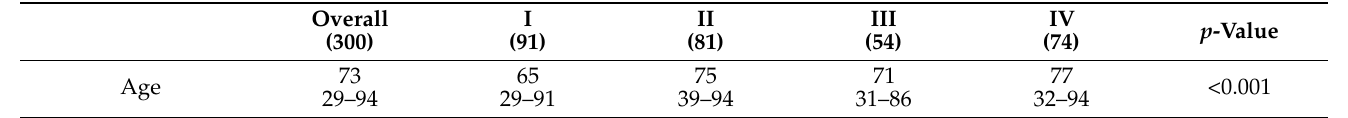
Table 1. Comparison of waves: clinical characteristics, anamnestic data, vital signs, prognostic scores, laboratory and arterial blood gas analyses at